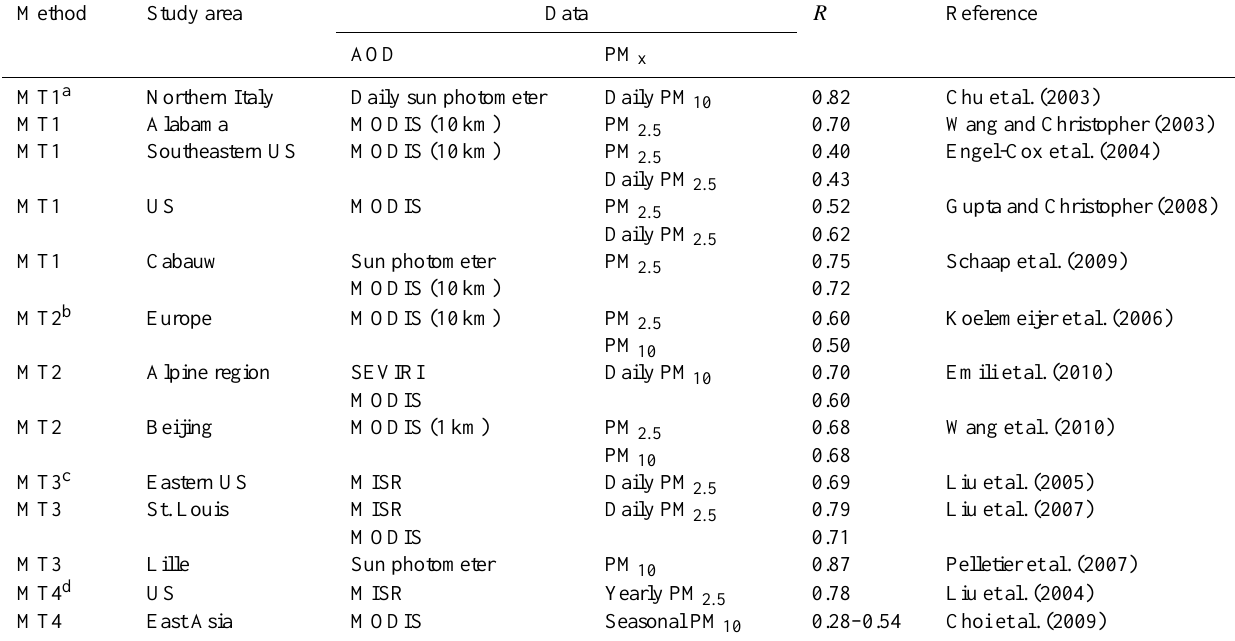
Table 1. Previous studies associated with the estimation of PM concentrations using AOD.